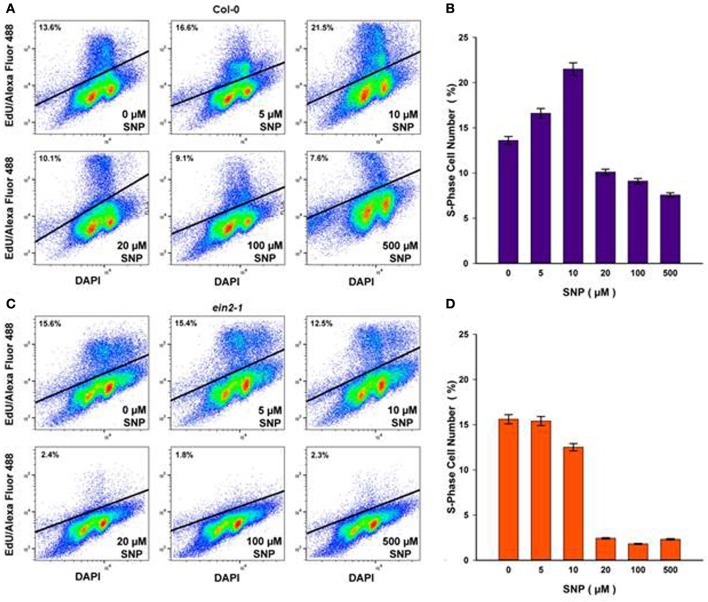
S-phase cells (%) in Col-0 (A,B) and ein2-1
(C,D) after 6-h treatment with SNP as detected by flow cytometry after incorporation of 5-ethynyl-2′-deoxyuridine (EdU) into DNA and the Click-iT reaction with azide of Alexa Fluor 488. Representative bivariate plots of DNA content (based on DAPI fluorescence) and EdU incorporation (based on Alexa fluor) are shown in (A) and (C). Above the solid line is a cluster of protoplasts having tag EdU–Alexa Fluor 488 (S-phase cells). Values in (B) and (D) are means ± SE of three independent biological experiments.